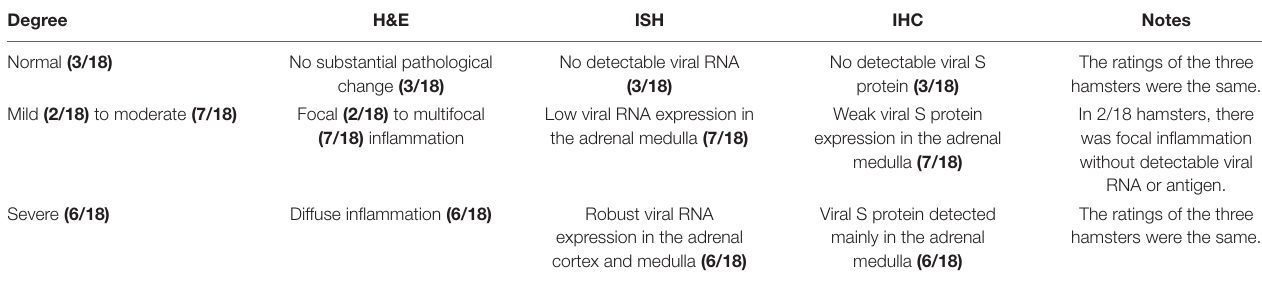
TABLE 2 | Summary of lesions in adrenal glands induced by SARS-CoV-2 at 7 dpi.